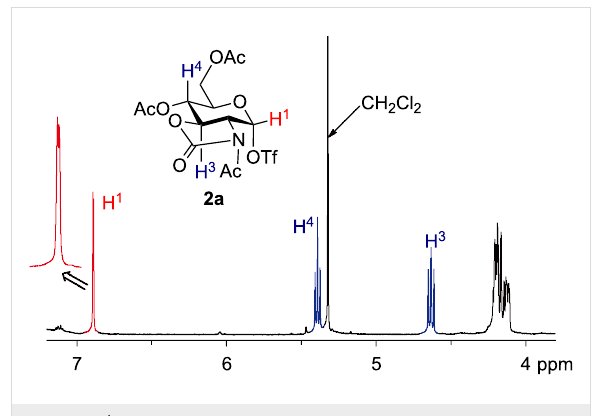
Figure 1: 1 H NMR spectrum of glycosyl triflate 2a .